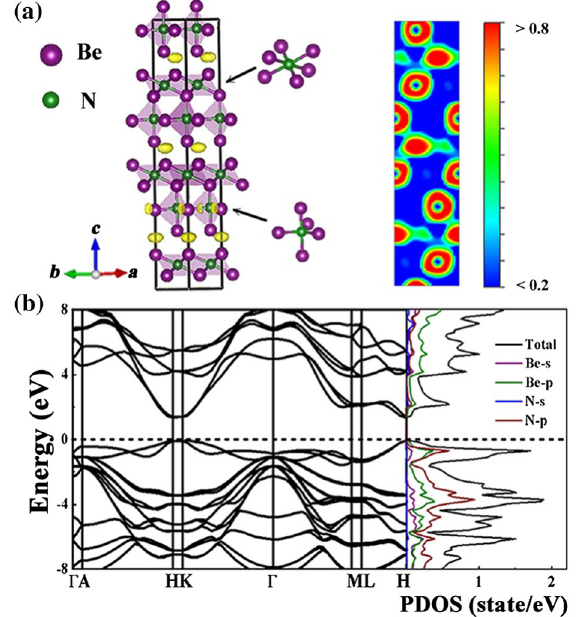
FIG. 7. Semiconducting Be 2 N as a 0D electride. (a) 3D ELF of Be 2 N (left-hand panel) with an isosurface value of 0.83. Sixfold and fivefold coordinated Be atoms are shown as structural units in the left-hand panel. The 2D ELF on the ð 110 Þ R plane in the right- hand panel shows the isolated interstitial localization regions consistentwiththe 3DELF.(b)Band structure andPDOSofBe 2 N. The HSE06 functional [47,48] corrects the DFT band gap of 1.51 eV to 1.96 eV. The dashed line indicates the Fermi energy ( E F